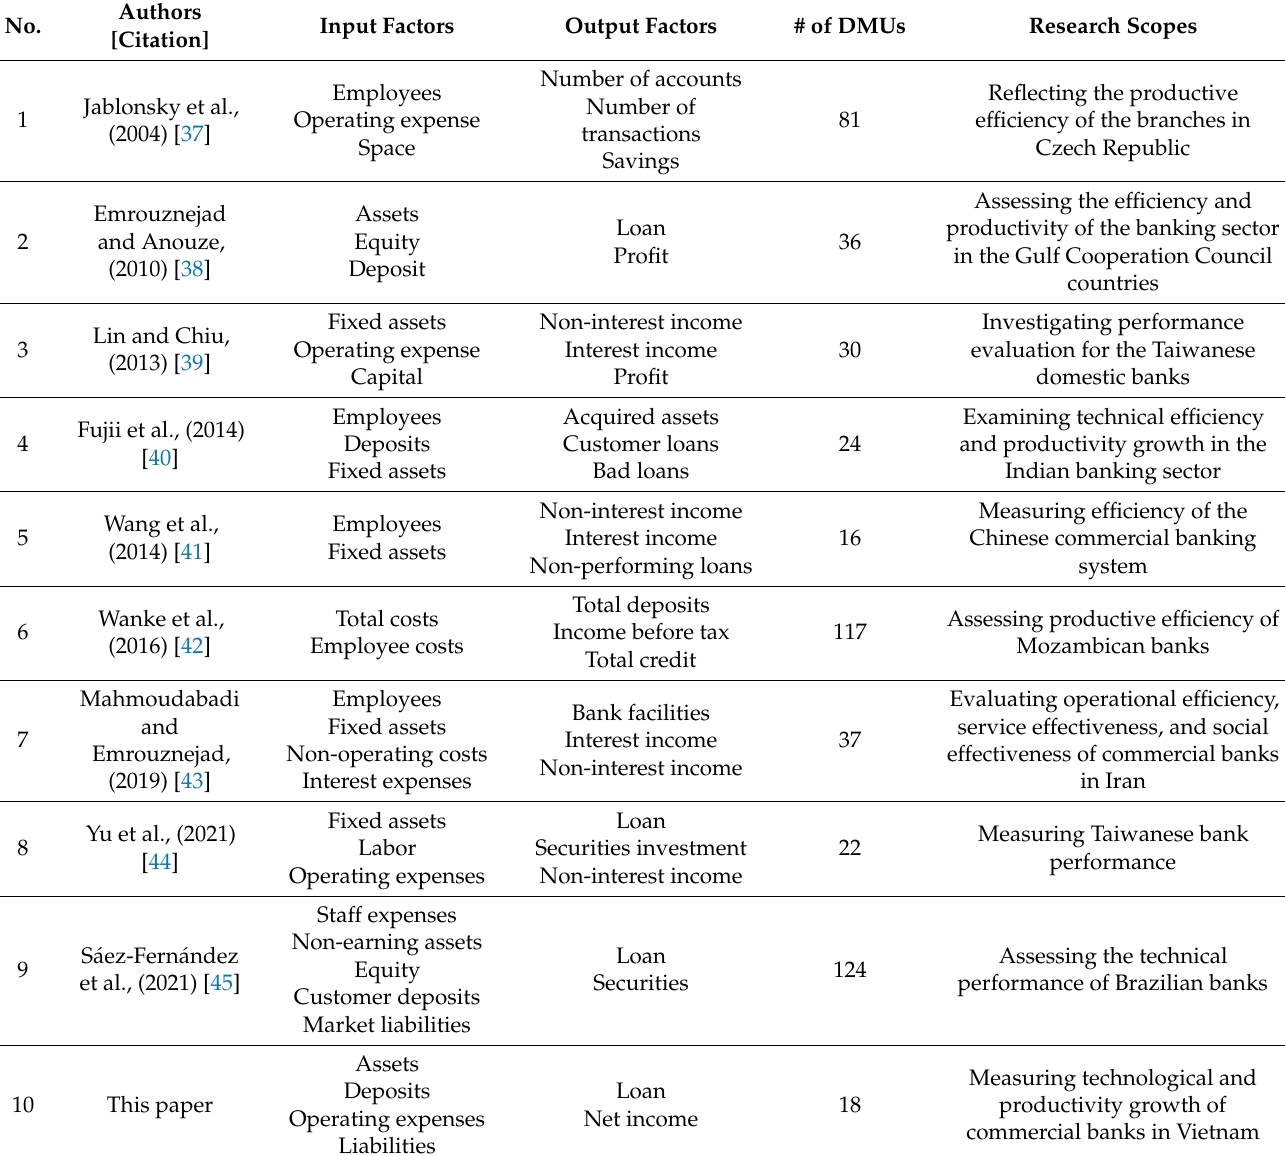
Table 1. List of common input and output factors used in previous